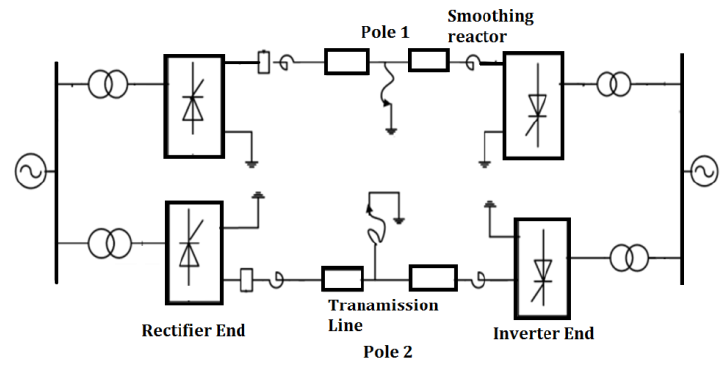
Figure 2. DC power network used.